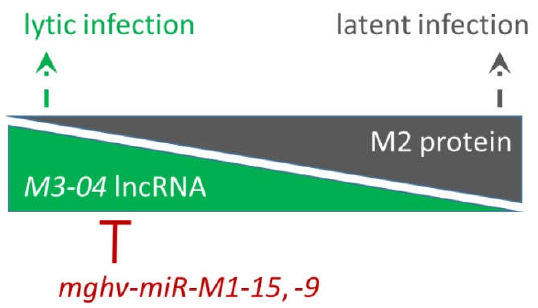
Figure 9. Working model for possible regulatory relationship between M3-04 lncRNA , M2 , and antisense miRNAs mghv-miR-M1-15 and -9 . During lytic infection, transcription of M3-04 lncRNA may interfere with the expression of M2 expression, facilitating lytic replication of the virus. In contrast, during latency, M3-04 transcript is not expressed and the expression of M2 protein facilitates B cell signaling and the establishment of latency. Antisense miRNAs may regulate the level of the M3-04 transcript in order to restrict lytic replication and/or to prevent leaky M3-04 expression during latency establishment.